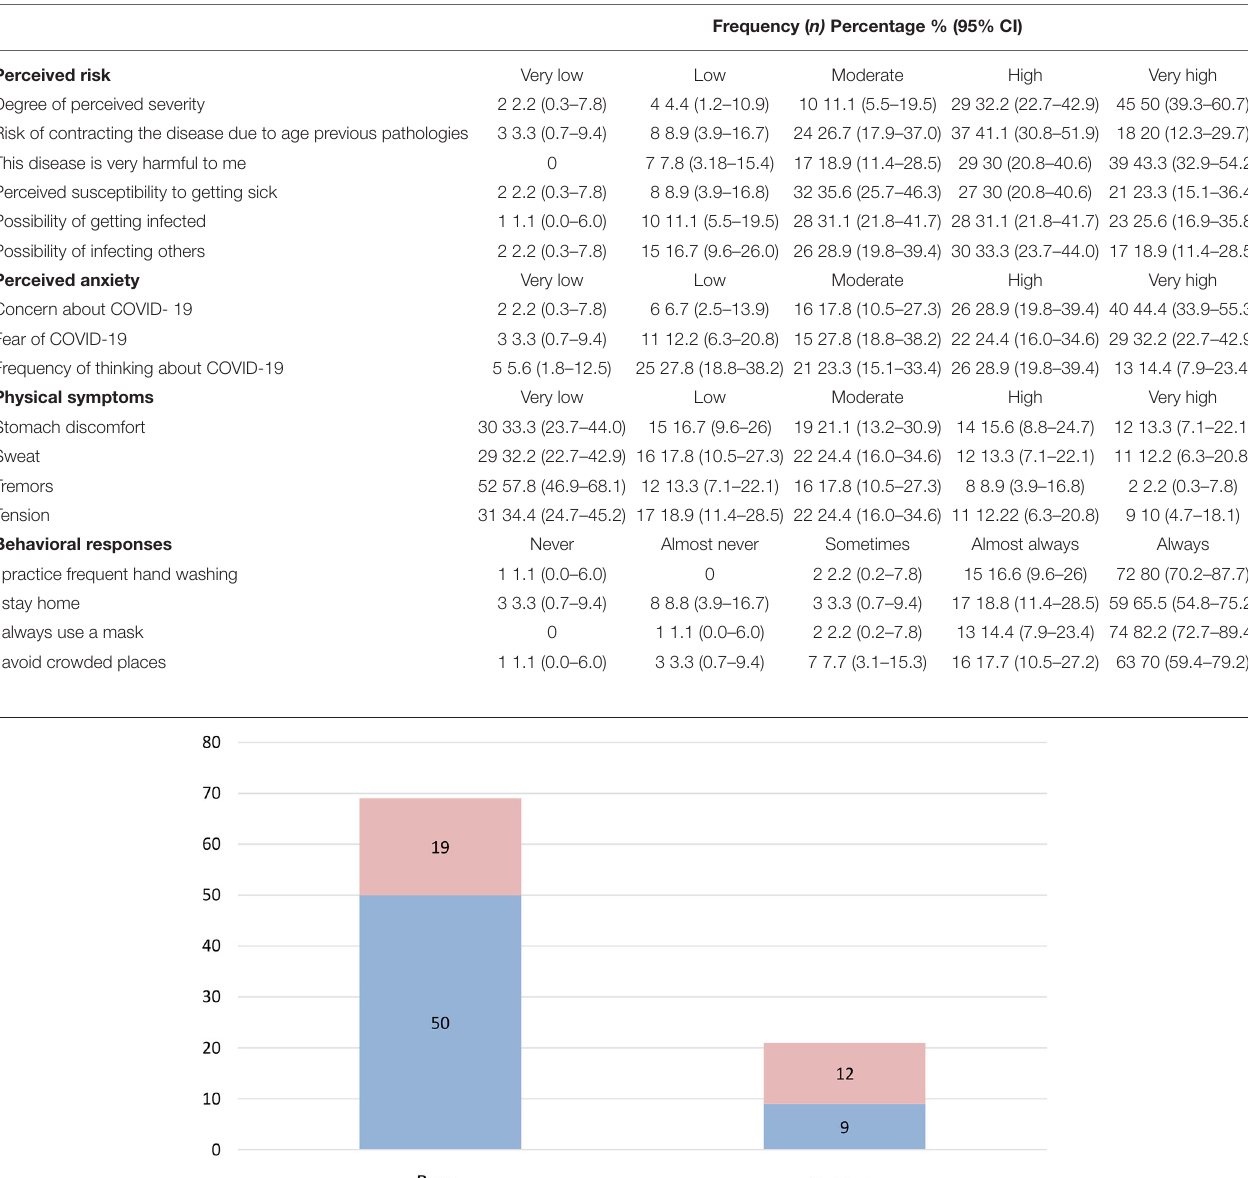
TABLE 2 | Descriptive data on risk and perceived anxiety, physical symptoms, and behavioral responses to coronavirus disease 2019 (COVID-19).